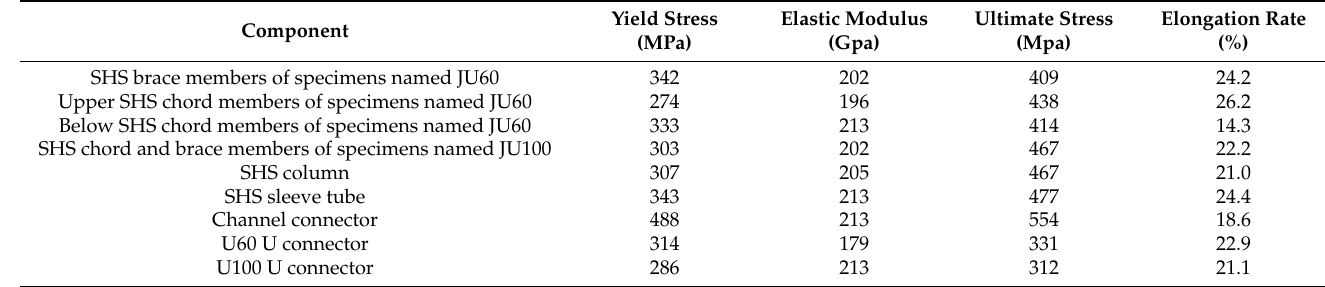
Table 1. Material properties of each steel.